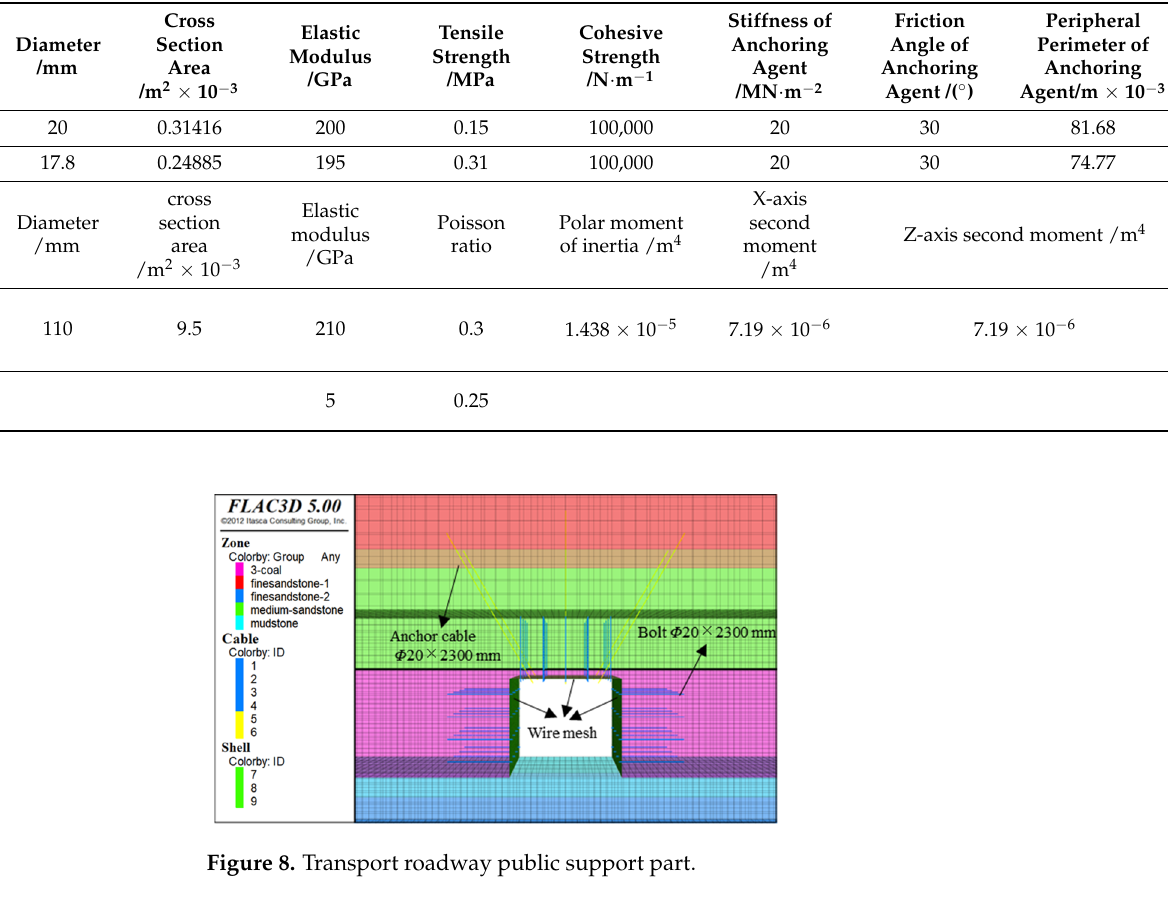
Table 4. Supporting material parameters.